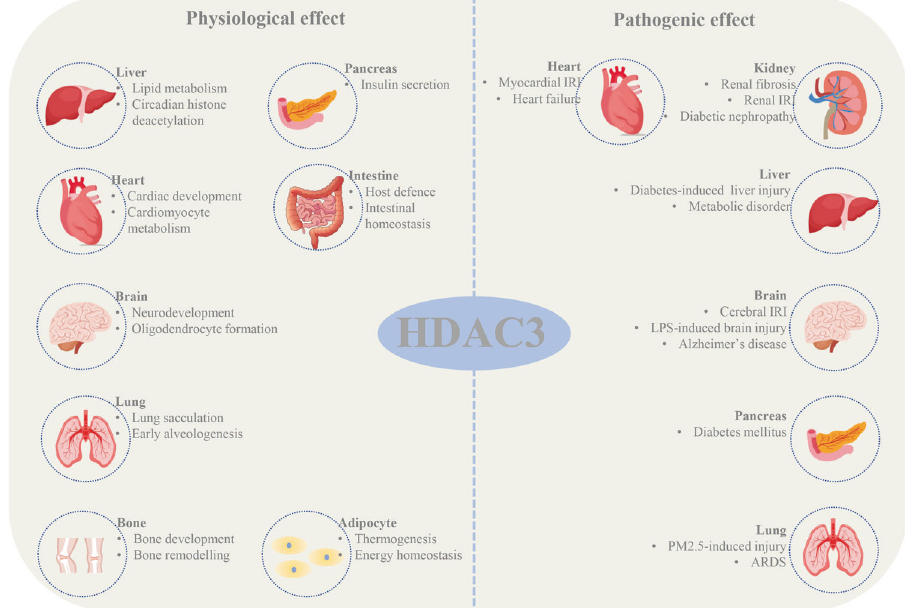
Fig. 3 The physiological functions and pathogenic effects of HDAC3. Under physiological condition, HDAC3 is mainly responsible for the development and homeostasis of liver, heart, brain, lung, bone, pancreas, intestine, and adipocyte. However, the abnormal expression of HDAC3 also contributes to organ injury including heart, brain, pancreas, kidney, lung, and